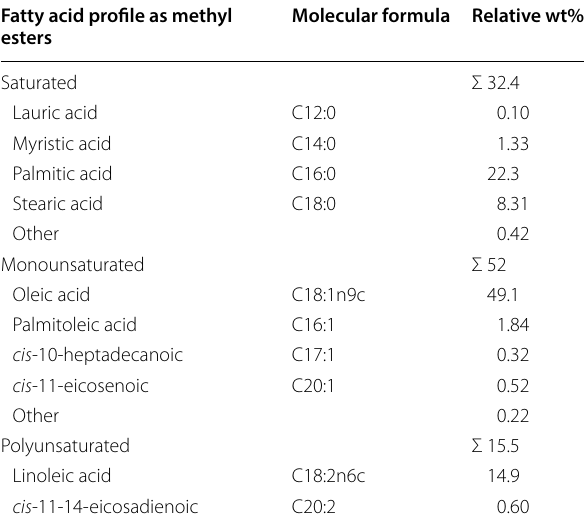
Table 10 Fatty acid methyl ester profile of